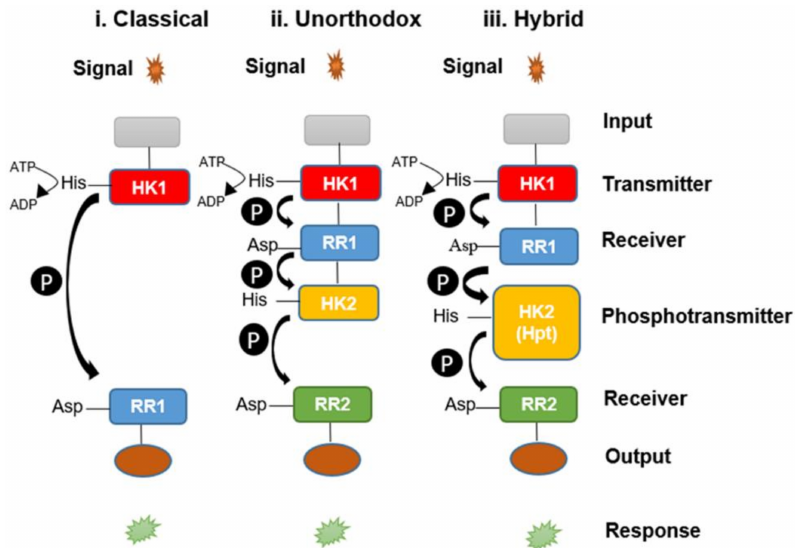
Figure 1. Classical-/Unorthodox-/hybrid signal transduction system modulation patterns: ( i ) the classical version comprises an N-terminal input domain, followed by a transmitter (HK1) with a conserved histidine that can be autophosphorylated. The phosphoryl group (P) is transferred to a conserved aspartic residue of RR1. The classical version is a two-step phosphorelay mechanism; ( ii ) in the unorthodox version, the HK1 is followed by an additional conserved aspartic residue (RR1) and an HK2. The phosphoryl group (P) is transferred to a conserved aspartic residue in the receiver (RR2) domain. The unorthodox version is a four-step phosphorelay mechanism; ( iii ) the hybrid version is similar to the unorthodox version, but HK2 (Hpt) is an external phosphotransfer module that acts as an individual protein. This figure was adapted from Liu et al.